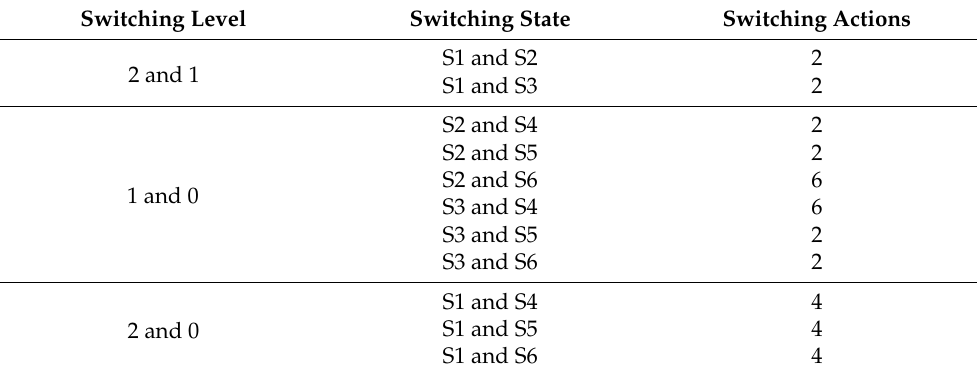
Table 3. The number of switching action when the output level switched between 0, 1 and 2.